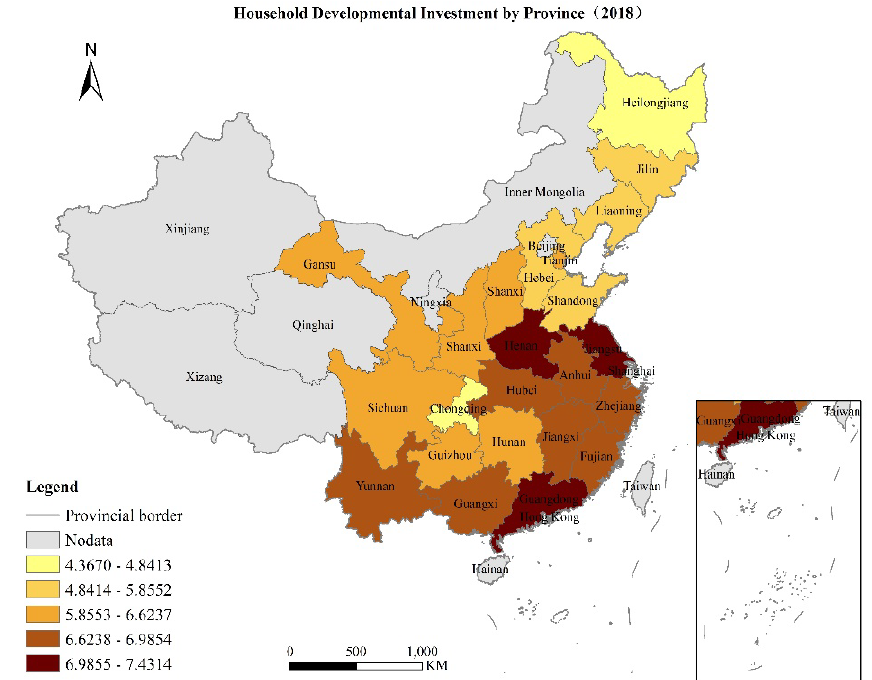
Figure 3. Household developmental investment by province (2018).